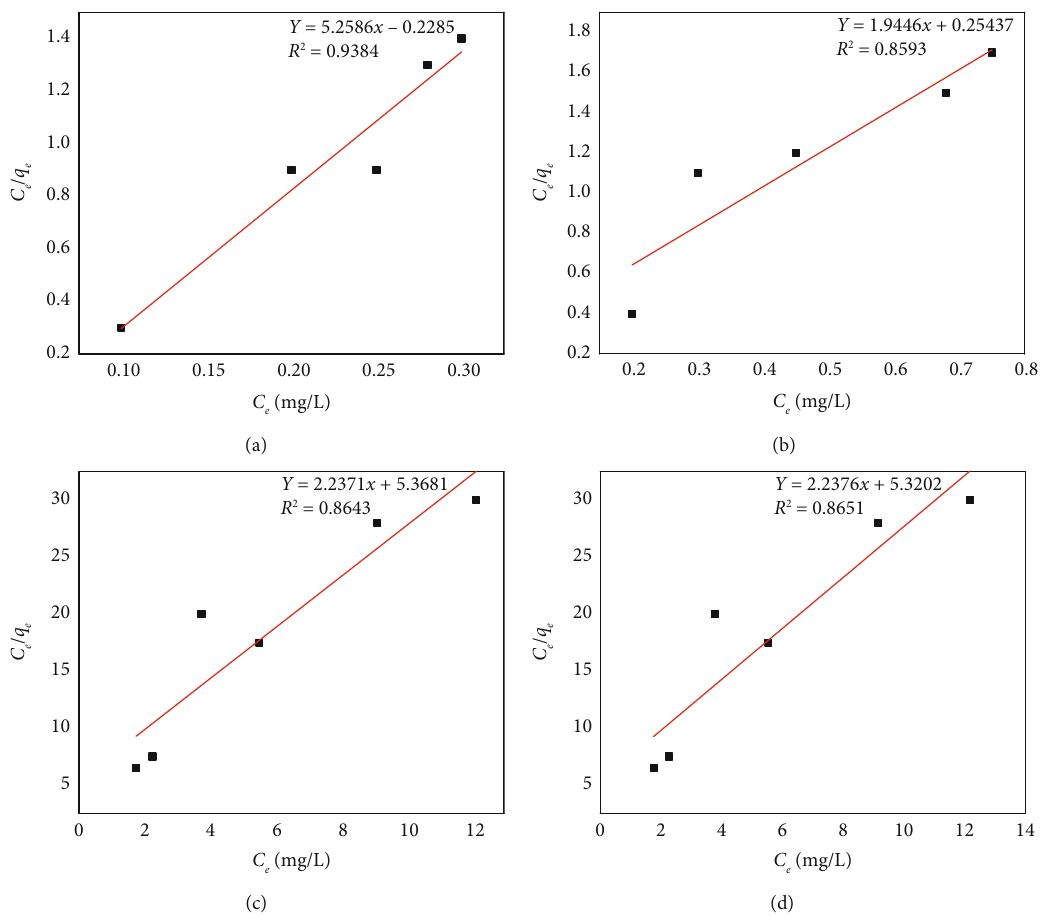
Figure 6: Langmuir adsorption isotherms for fl uoride adsorption by TAADFPs activated at (a) 450 ° C, (b) 500 ° C, (c) 550 ° C, and (d) 600 °